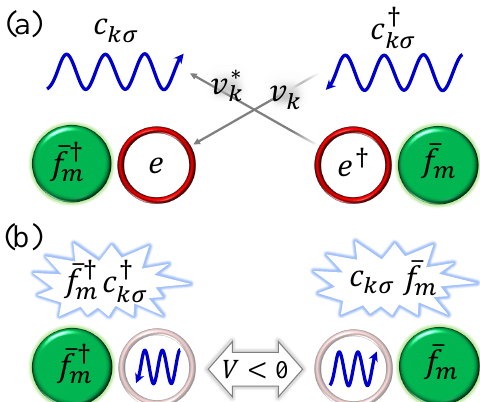
Figure 1: Illustration of the valence fluctuation mediated attractive potential. (a) The unoccupied state (holon) in each valence fluctuation term can attract another conduction electron through the valence fluctuation channel. The conjugate pro- cess also occurs simultaneously. Wavy lines depict conduction electrons ( c , c † ), while filled ( ¯ f , ¯ f † )) and open ( e , e † ) circles give singly occupied and unoccupied f -sites, re- spectively. Bar symbol over f -operators emphasizes that they are single- f -electrons occupied states. Arrows dictate valence fluctuation channels. (b) As we integrate out the unoccupied states ( e , e † ), we obtain an effective interaction V < 0, forming Cooper pair between the single site ¯ f -electron and conduction c